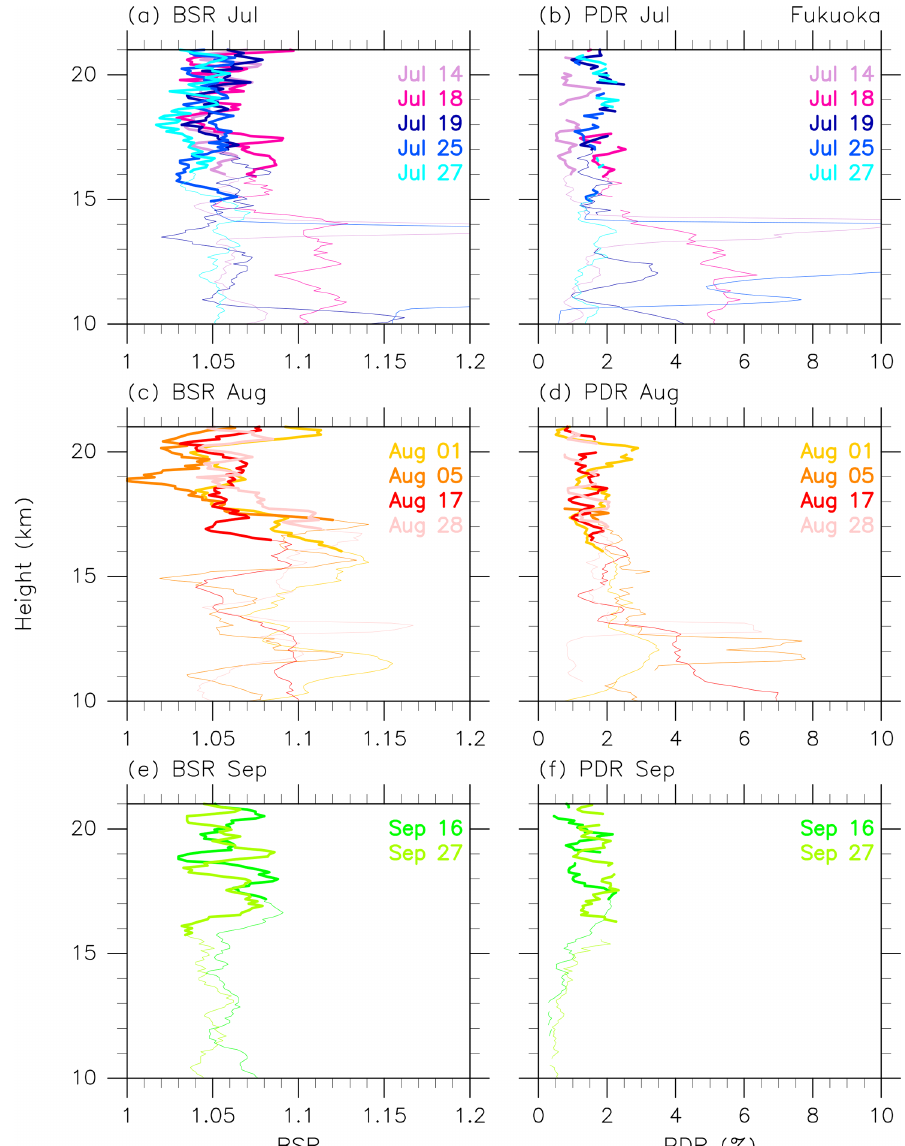
Figure 3. A total of 11 vertical profiles of (a, c, e) the backscattering ratio (BSR) and (b, d, f) particle depolarization ratio (PDR, in %) in (a, b) July, (c, d) August, and (e, f) September 2018 obtained using the lidar system at Fukuoka. Dates and colours are assigned in the legend where, for example, “Jul 14” refers to the night of 14–15 July. The stratospheric portion of the profiles has been thickened using the daily (first) lapse-rate tropopause location information provided by the JMA based on operational 21:00LT radiosonde data taken at the JMA Fukuoka site (at a ∼ 4km distance from the lidar